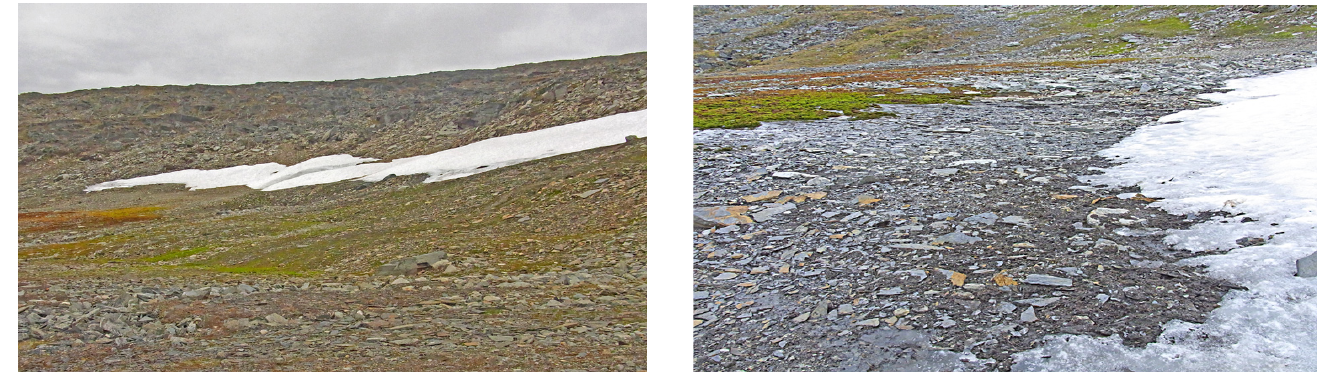
Figure 13: Left. Slåttatjåkka snow/ice patch (9), 1190 m a.s.l. 2010-08-29. Right. Slåttatjåkka snow/ice patch, 1025 m a.s.l.